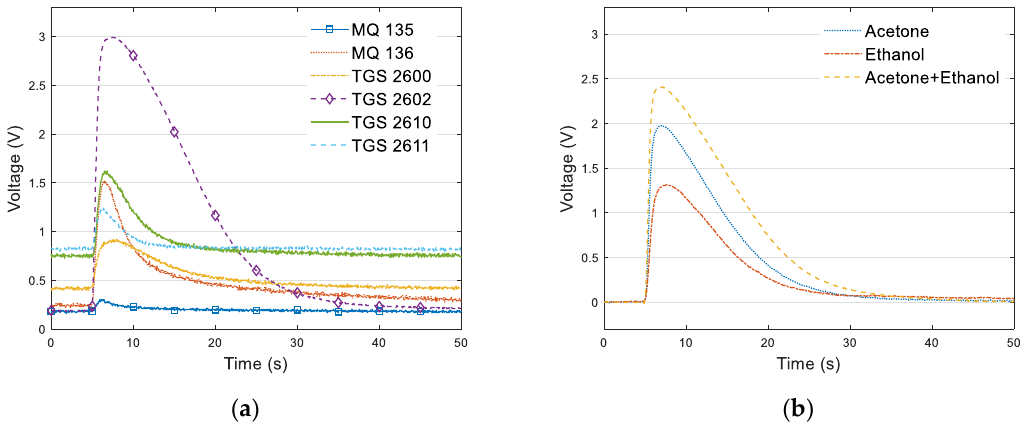
Figure 2. ( a ) Responses of the 6 metal-oxide-semiconductor (MOS) sensors toward acetone; ( b ) single and mixed gas response curve of TGS 2602.